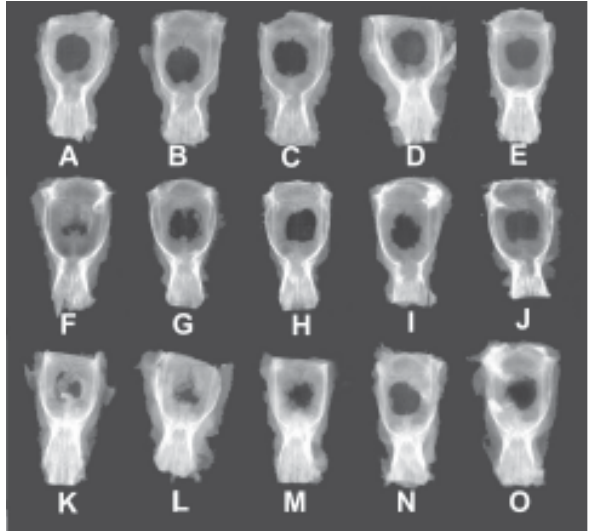
FIGURE 4.- Radiographic images of 1-month ( A-E ), 3-month ( F-J ) and 6-month ( L-P ) experimental